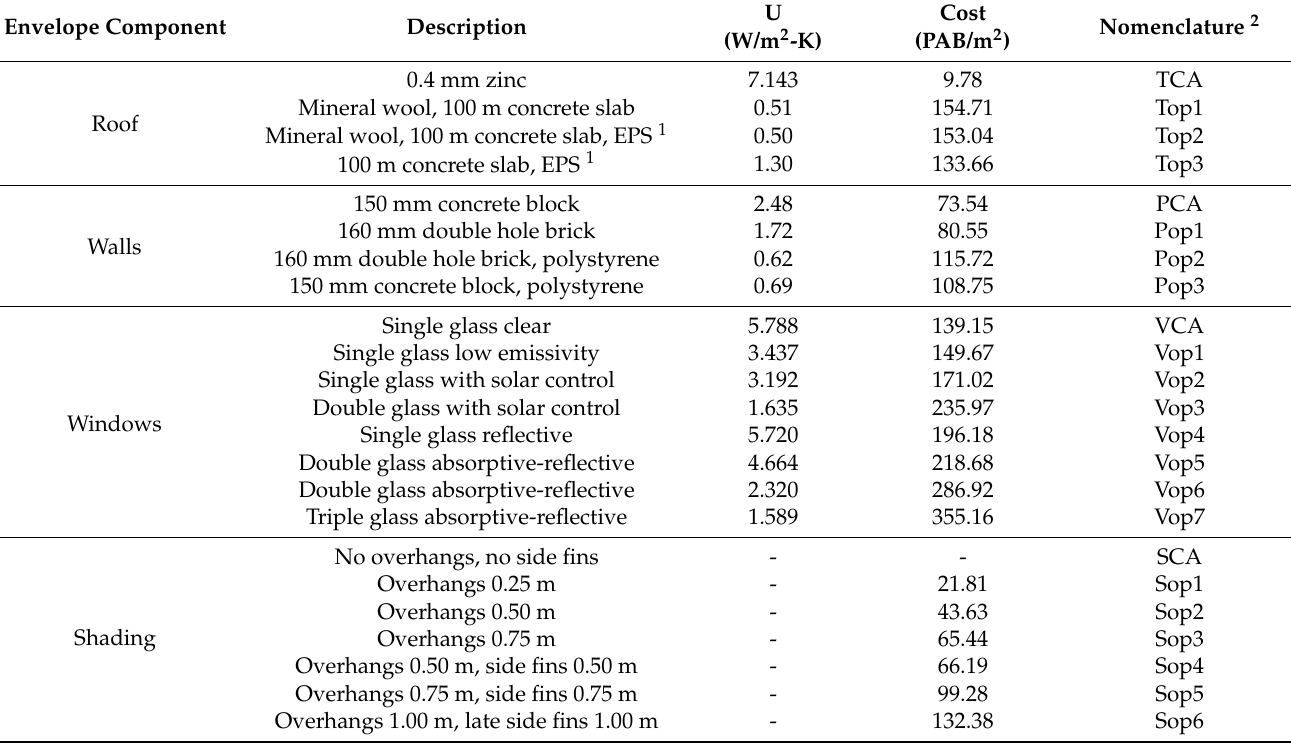
Table 4. Original envelope component and design options obtain from optimization analysis.